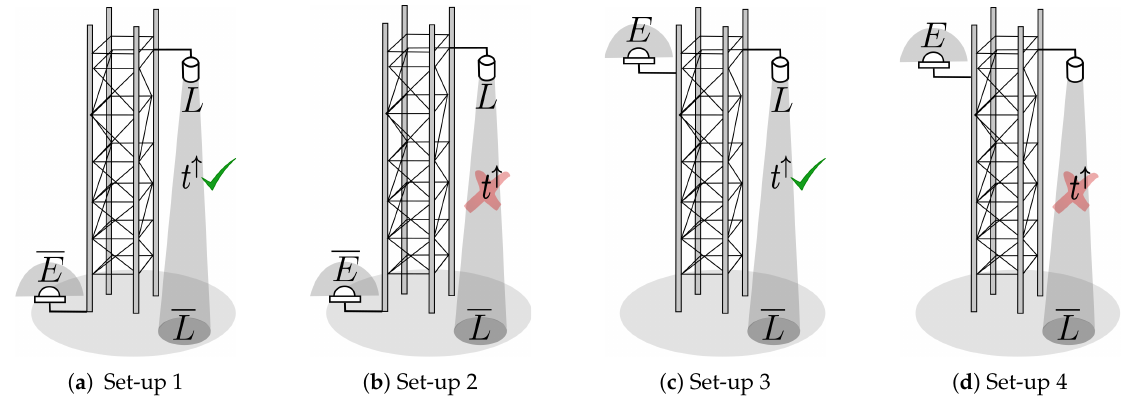
Figure 5. Diagrams in ( a – d ) corresponding to the instrument set–up configurations (1), (2), (3) and (4), respectively, described in Section 4.1. ( d ) represents the common configuration of tower–mounted instruments to measure SIF at tower–scale. In some cases, downward looking sensors mounted at the tower 's top allow multi–angular data collections. Down–welling solar irradiance is typically acquired with upward looking hemispherical or conical systems or by measuring a reference panel with a downward looking sensor. Here t ↑ is the upward atmospheric